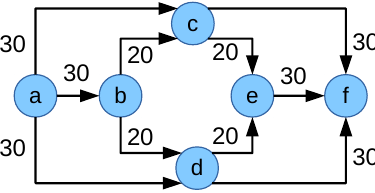
Figure 17. Topology of scenarios 19 and 20: Three alternative connections for flow [ a,f ] via c, b or d. The numbers specify the link speeds in